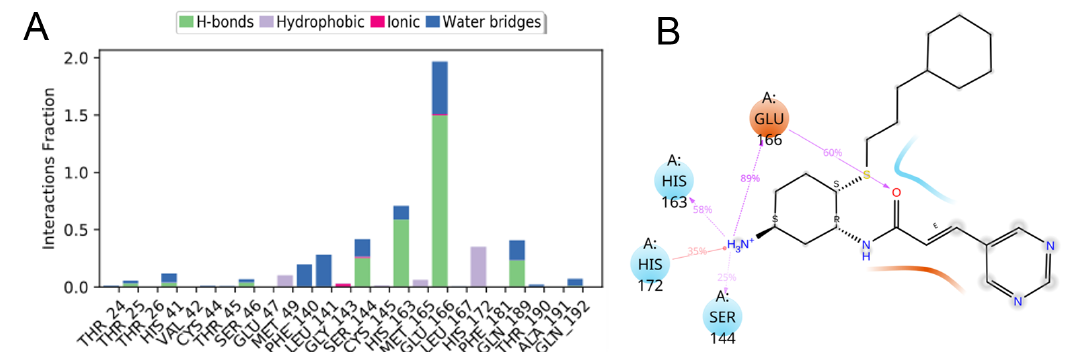
Figure 20. Analysis of ( A ) molecular interactions; and ( B ) type of contacts (2D interaction contour map with the key protein residues) for CM06 with SARS-CoV-2 M pro (PDB ID: 6LU7) after MD simulation. Interactions that lasted more than 10% of the simulation time were considered.